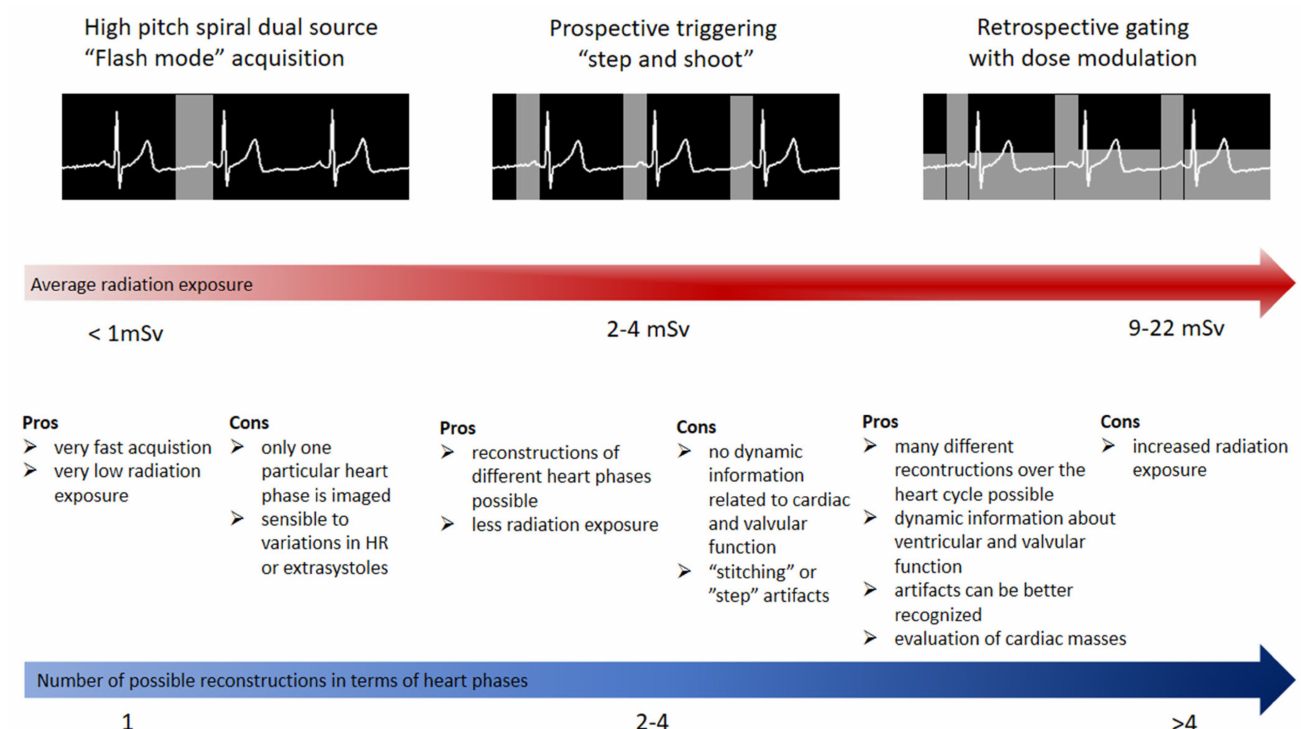
Figure 1. Scan modes used in coronary computer tomography angiography with advantages and disadvantages as well as radiation exposure for each of the different acquisition